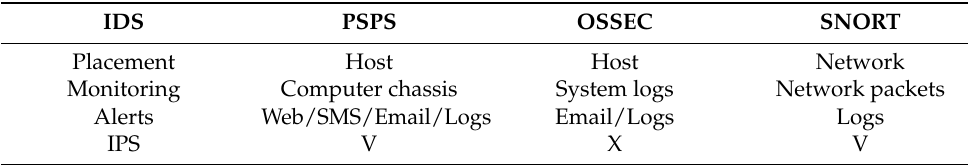
Table 2. PSPS vs. HIDS-OSSEC vs. NIDS-SNORT.